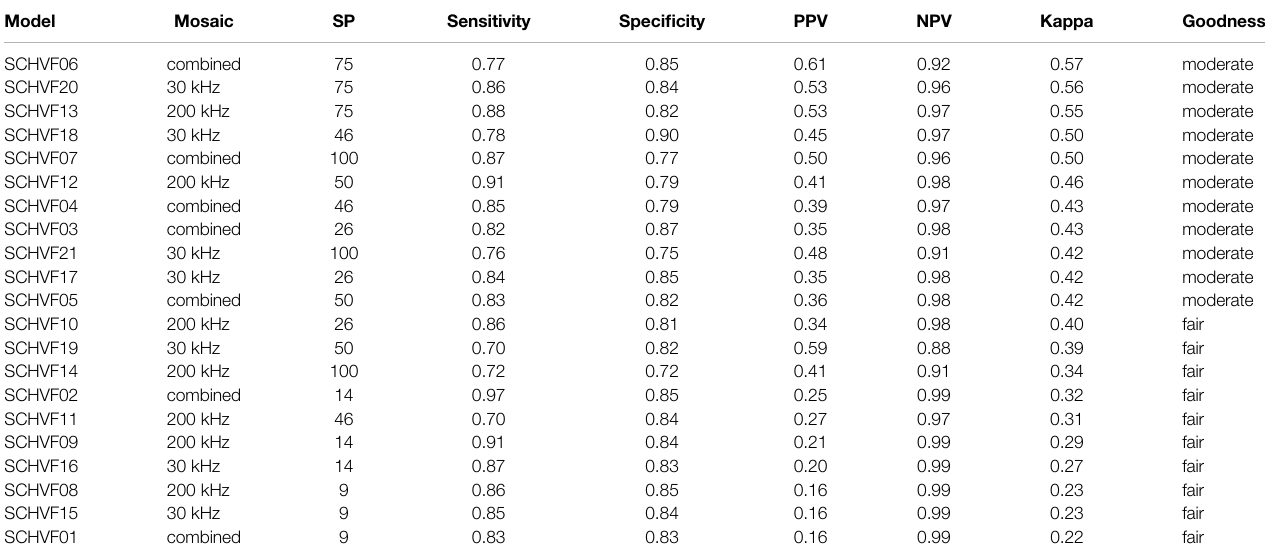
TABLE 4 | South Calypso HVF random forest results ordered by Kappa score.